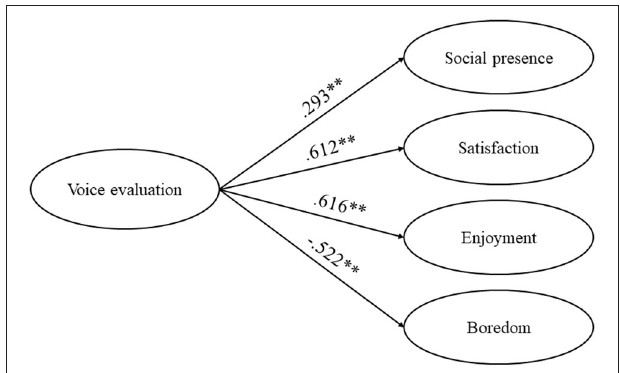
FIGURE 4 | Results of the linear regression of voice evaluation on each